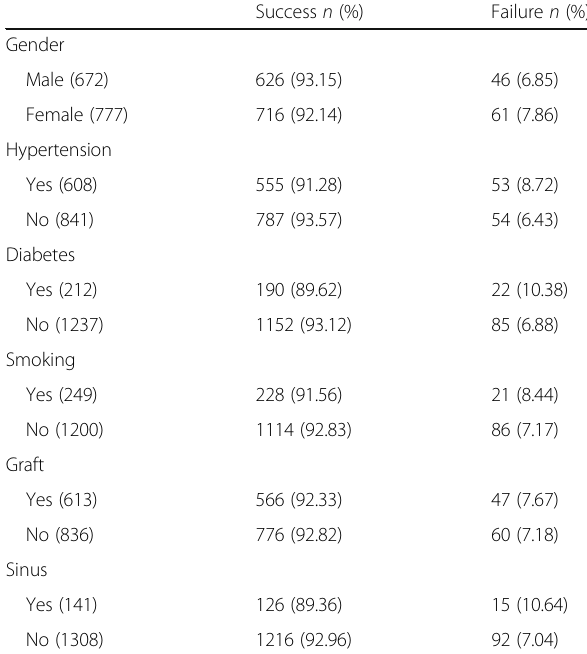
Table 1 Population demographics outlining the distribution of implant outcomes. Mean age of the population 59.65 years